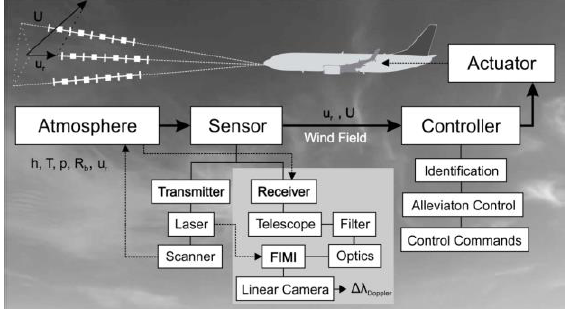
Figure 1: Lidar-based feed-forward gust alleviation system (the grey-shaded box is treated